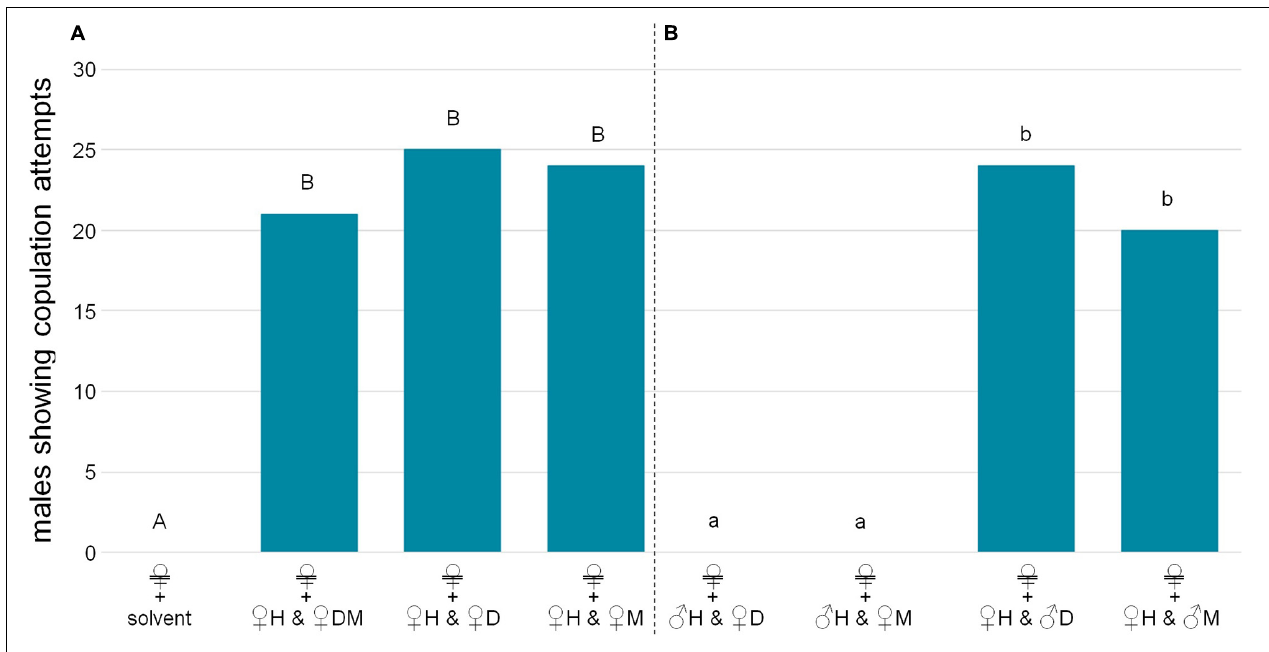
FIGURE 4 | Bioactivity of combinations of extract fractions. Extracts were applied to a silica gel cartridge and eluted with hexane (H, non-polar fraction containing cuticular hydrocarbons), dichloromethane (D, fraction containing lipids of relatively low to medium polarity) and methanol (M, fraction containing lipids of relatively high polarity). (A) Males showed a similar number of copulation attempts toward Soxhlet-extracted females treated with the female-derived H fraction in combination with one or both of the remaining female-derived fractions. (B) The male-derived H fraction in combination with female-derived D or M fractions was not bioactive, while female-derived H fraction elicited copulation attempts despite being presented in combination with male-derived D or M fractions. Significant differences in male reactions are depicted by different letters [ χ 2 tests with Bonferroni-Holm correction, (A) capital letters, (B) lower case letters. In all significant cases p < 0.001, n = 30 for each